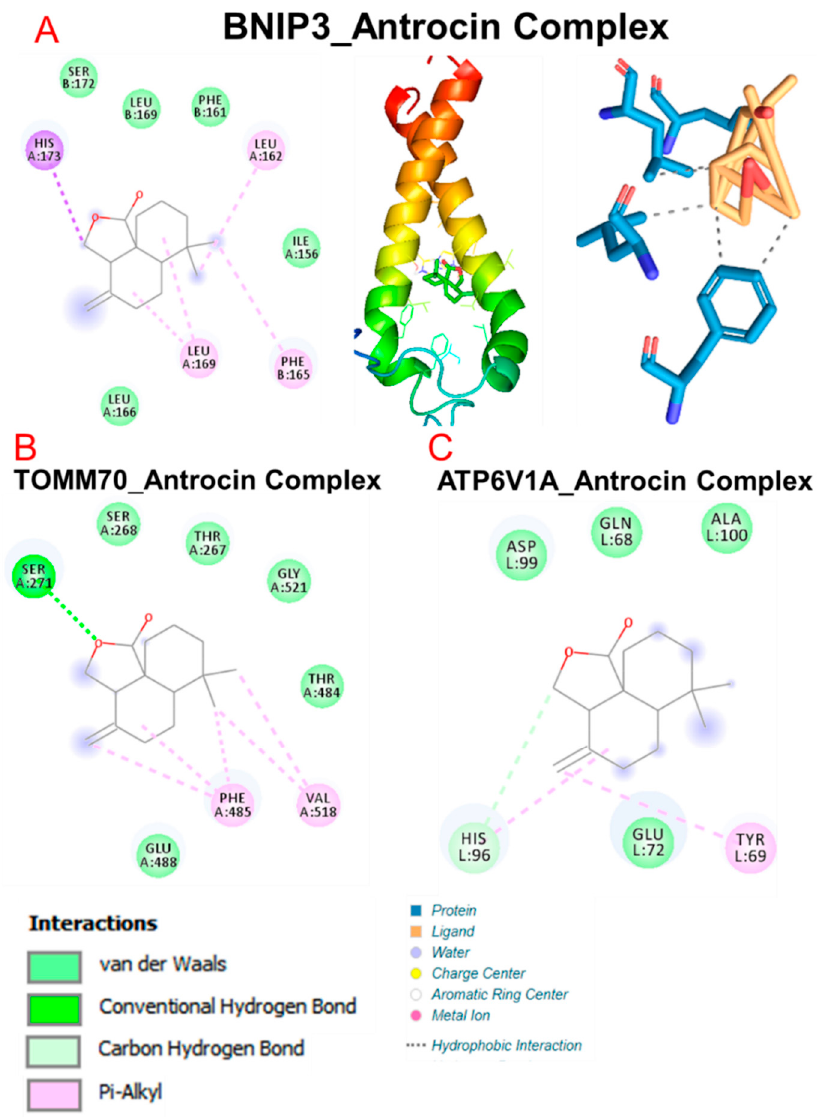
Figure 10. Molecular docking profiles of BNIP3, TOMM70, and ATP6V1A with antrocin. The two dimensional structure of the receptor-ligand complexes formed between antrocin and ( A ) BN1P3 ( B ) TOMM70, and ( C ) ATP6V1A Table 6. Molecular docking profiles between antrocin and various targets.